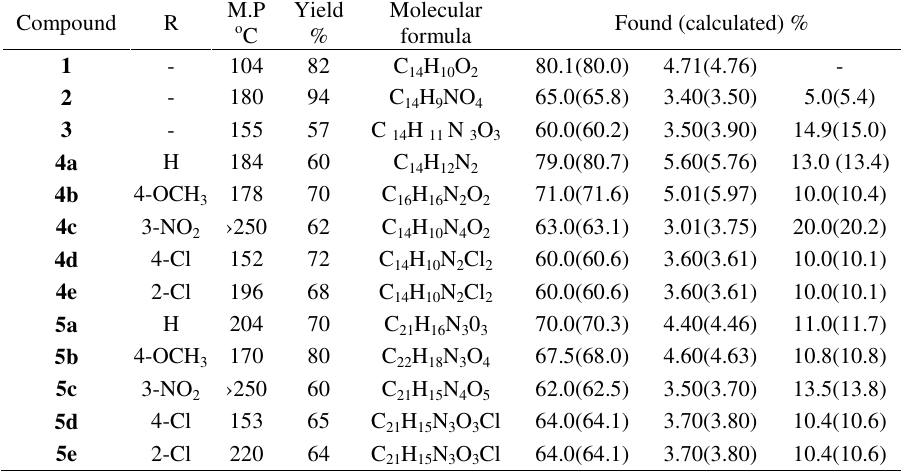
Table 1. Analytical data of the synthesized